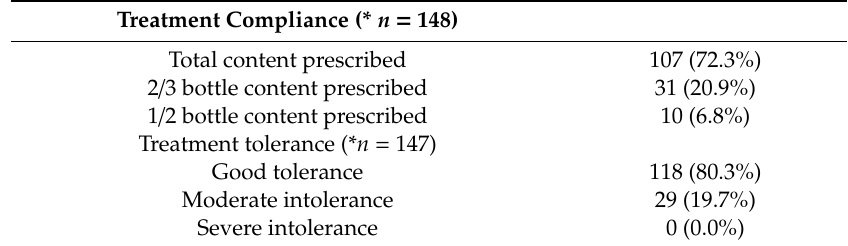
Table 2. Compliance and tolerance to oligomeric enteral nutrition (OEN) after 8 weeks of